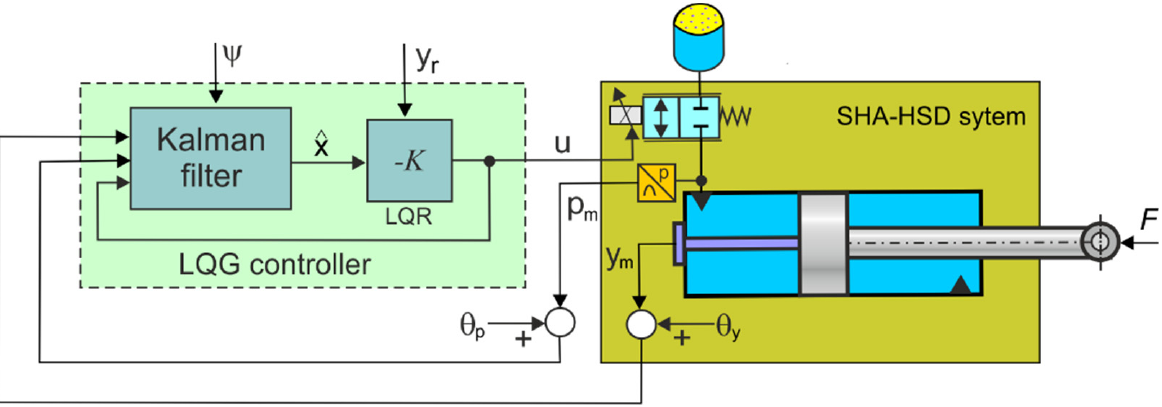
Figure 17. Schematic diagram of the LQG controller for an SHA-HSD control system. The dynamic model (47) of an SHA-HSD system was written as a discrete-time linear state-space